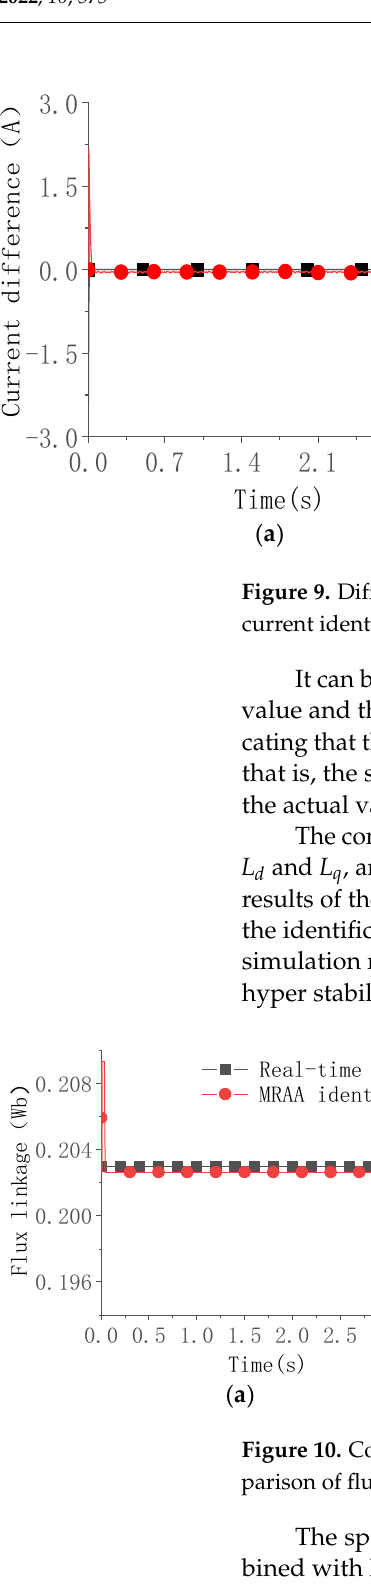
Figure 11. Comparison between the MRAA-identified L d and the actual L d . ( a ) Comparison of L d and ( b ) the local magnification of the anterior segment. 0.0 0.5 1.0 1.5 2.0 2.5 3.00.005250 0.0053750.0055000.005625 Lq （ H ） ( b ) Figure 12. Comparison between the MRAA-identified L q and the actual L q . ( a ) Comparison of L q and ( b ) the local magnification of the anterior segment.